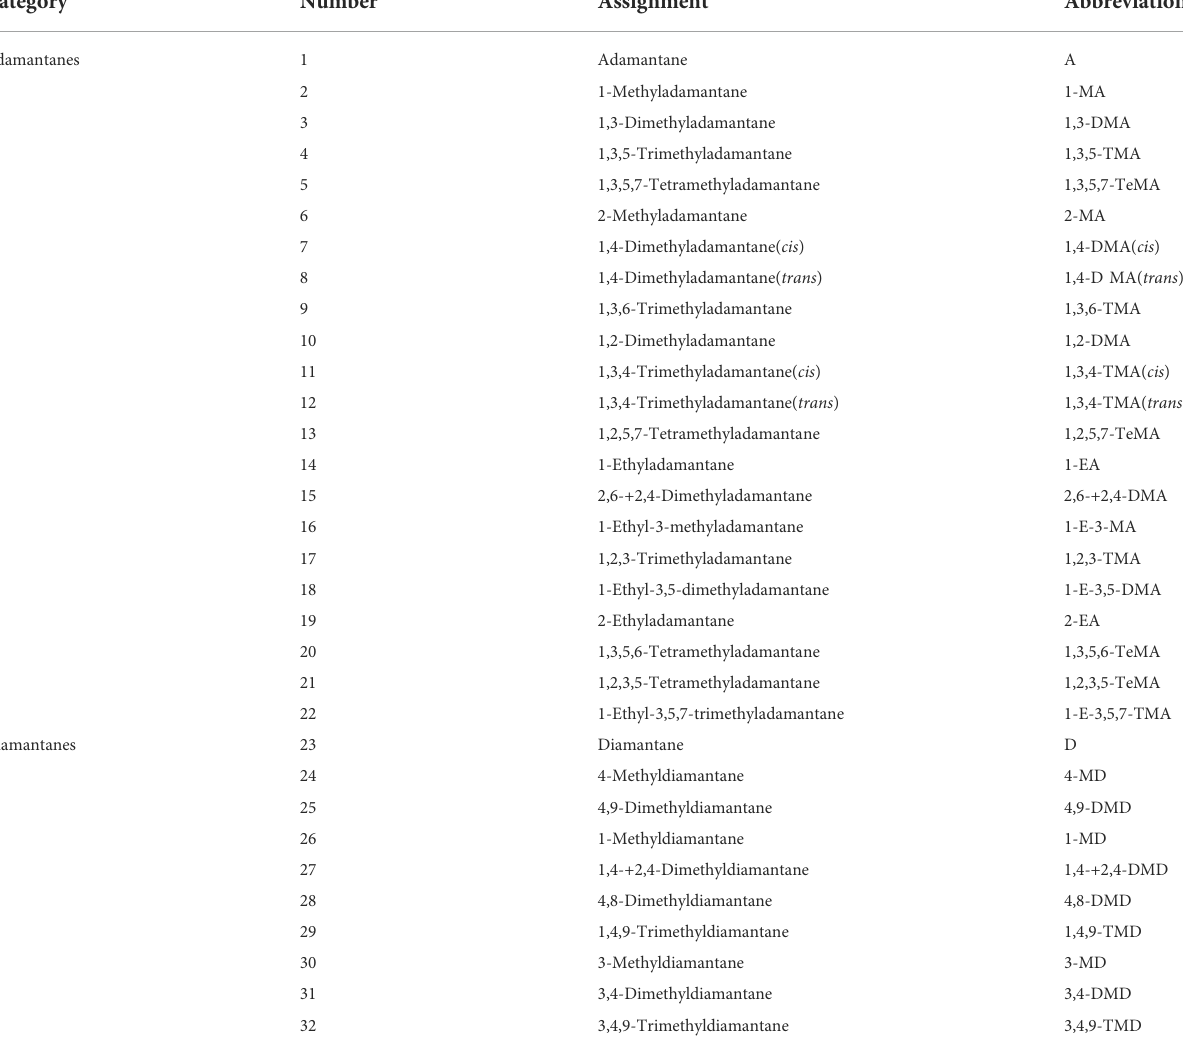
TABLE 1 Diamondoids (adamantanes and diamantanes) identi fi ed in this work.